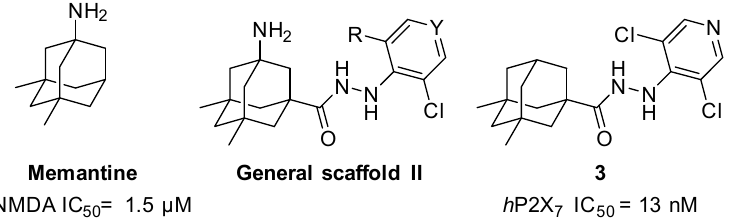
Figure 1. Rational design of the first generation of analogues.